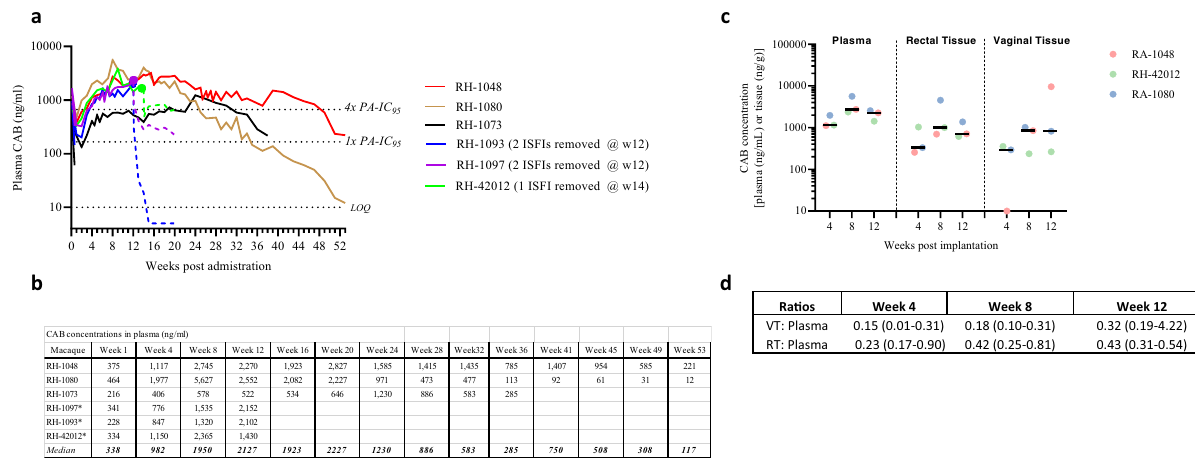
Fig. 4 | Cabotegravir concentrations in plasma and tissuesin rhesus macaques treated with two CAB ISFIs. a Longitudinal assessment of CAB concentrations in plasma. The two CAB ISFIs were removed from macaques RH-1097 and 1093 (blue andpurplesolidcircles)atweek12andoneofthetwoCABISFIswasremovedfrom macaque RH-42012 atweek 14(green solid circle).Dottedlines indicate CABlevels post removal. b Asterisk (*) indicates animals with ISFIs removed at weeks 12 – 14.